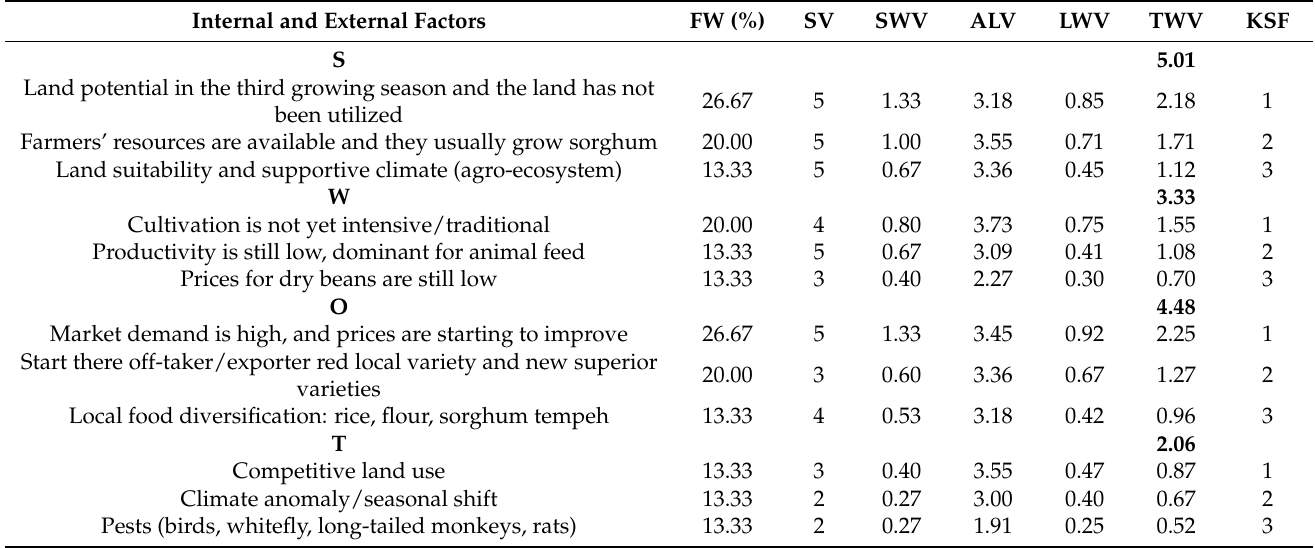
Noted: Source = Primary Data 2022 (processed). Table 6. Evaluation of internal and external factors in sorghum development in Gunungkidul Yogyakarta, 2022.